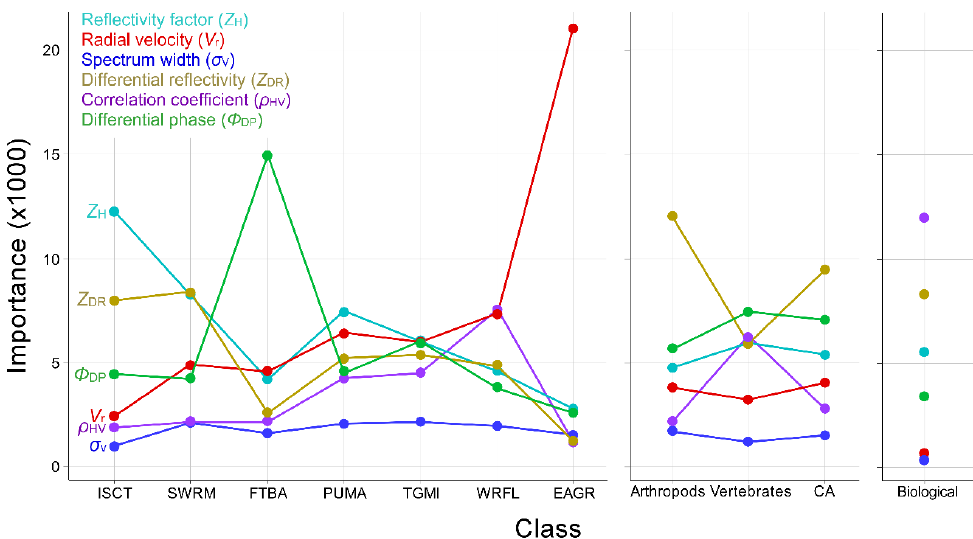
Figure 3. Variable importance indices generated by separate binary RF models trained to distinguish between a focal biological class (shown) and a class that drew samples equitably from all